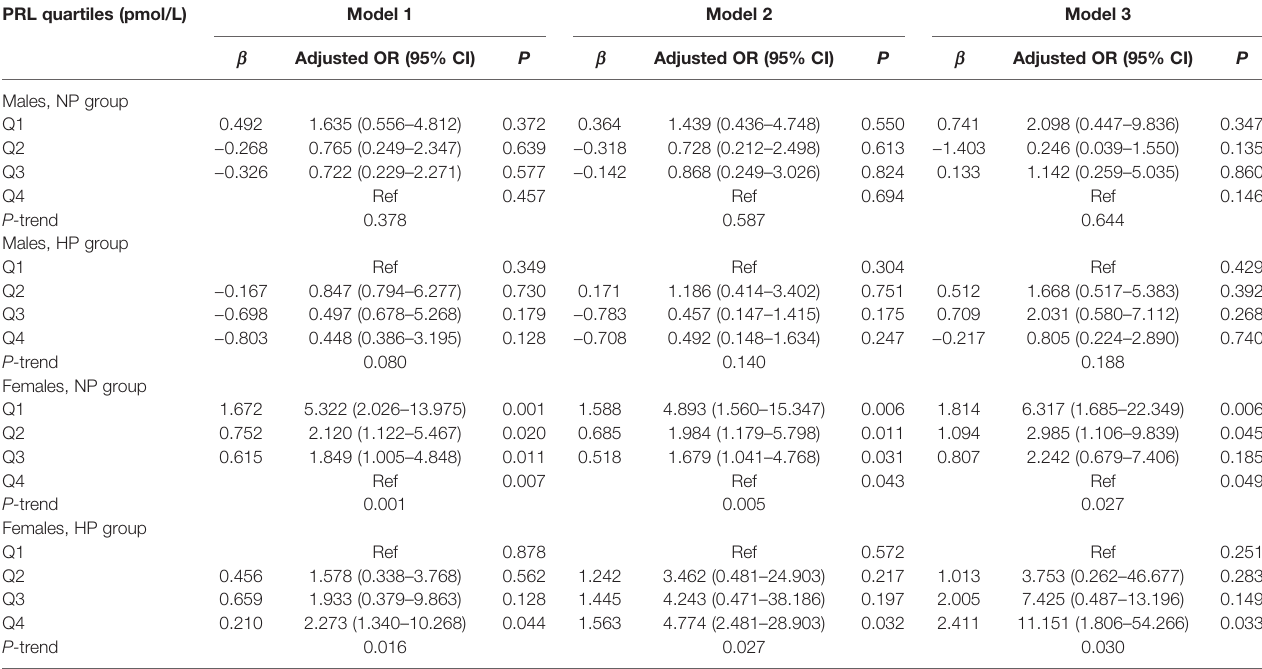
TABLE 4 | Multiple-adjusted odds ratios (AORs) and 95% con fi dence intervals (95% CI) for liver fi brosis, according to serum PRL quartiles: results of binary logistic regression analysis in different models. PRL quartiles